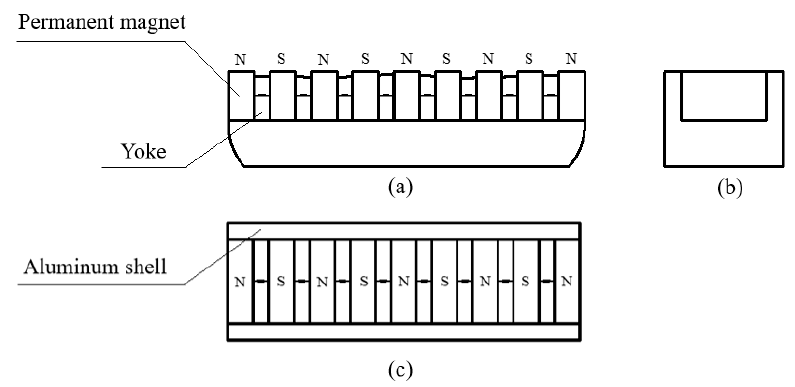
Figure 3. Structure of adhesion mechanism: ( a ) Left view; ( b ) front view; ( c ) bottom view.